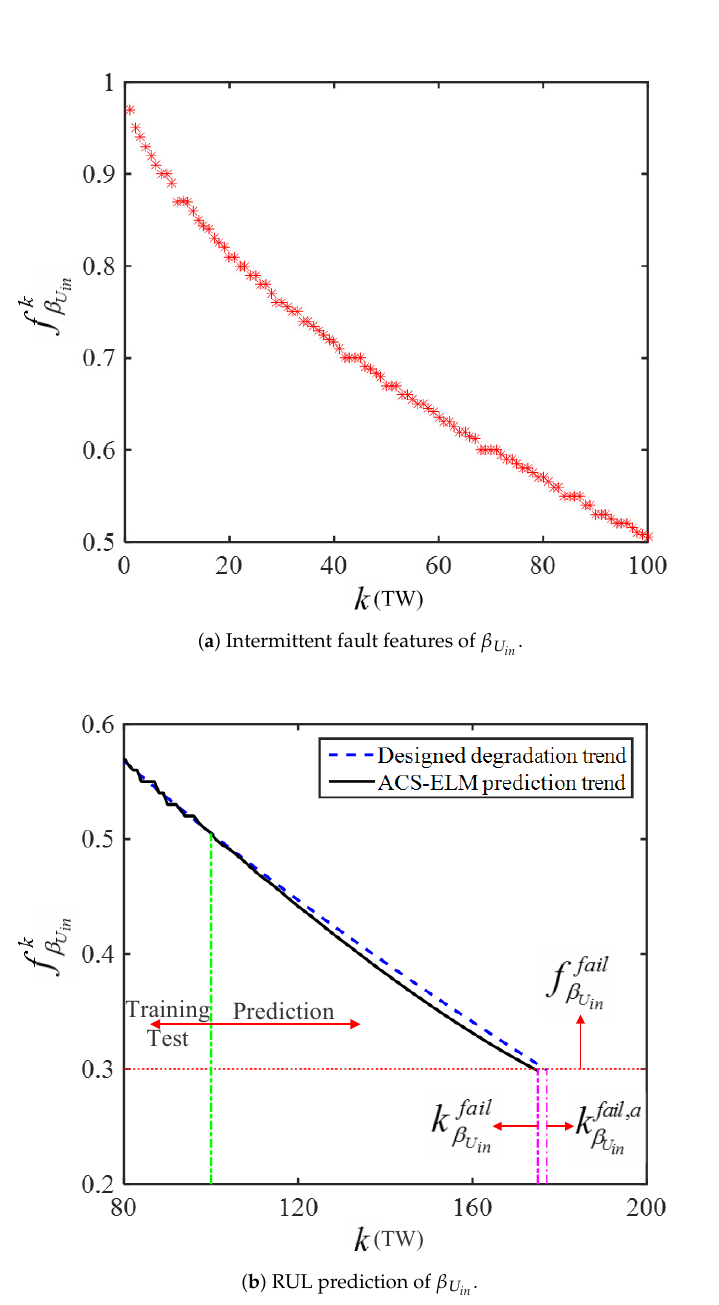
Figure 6. Estimation and prediction results of β U